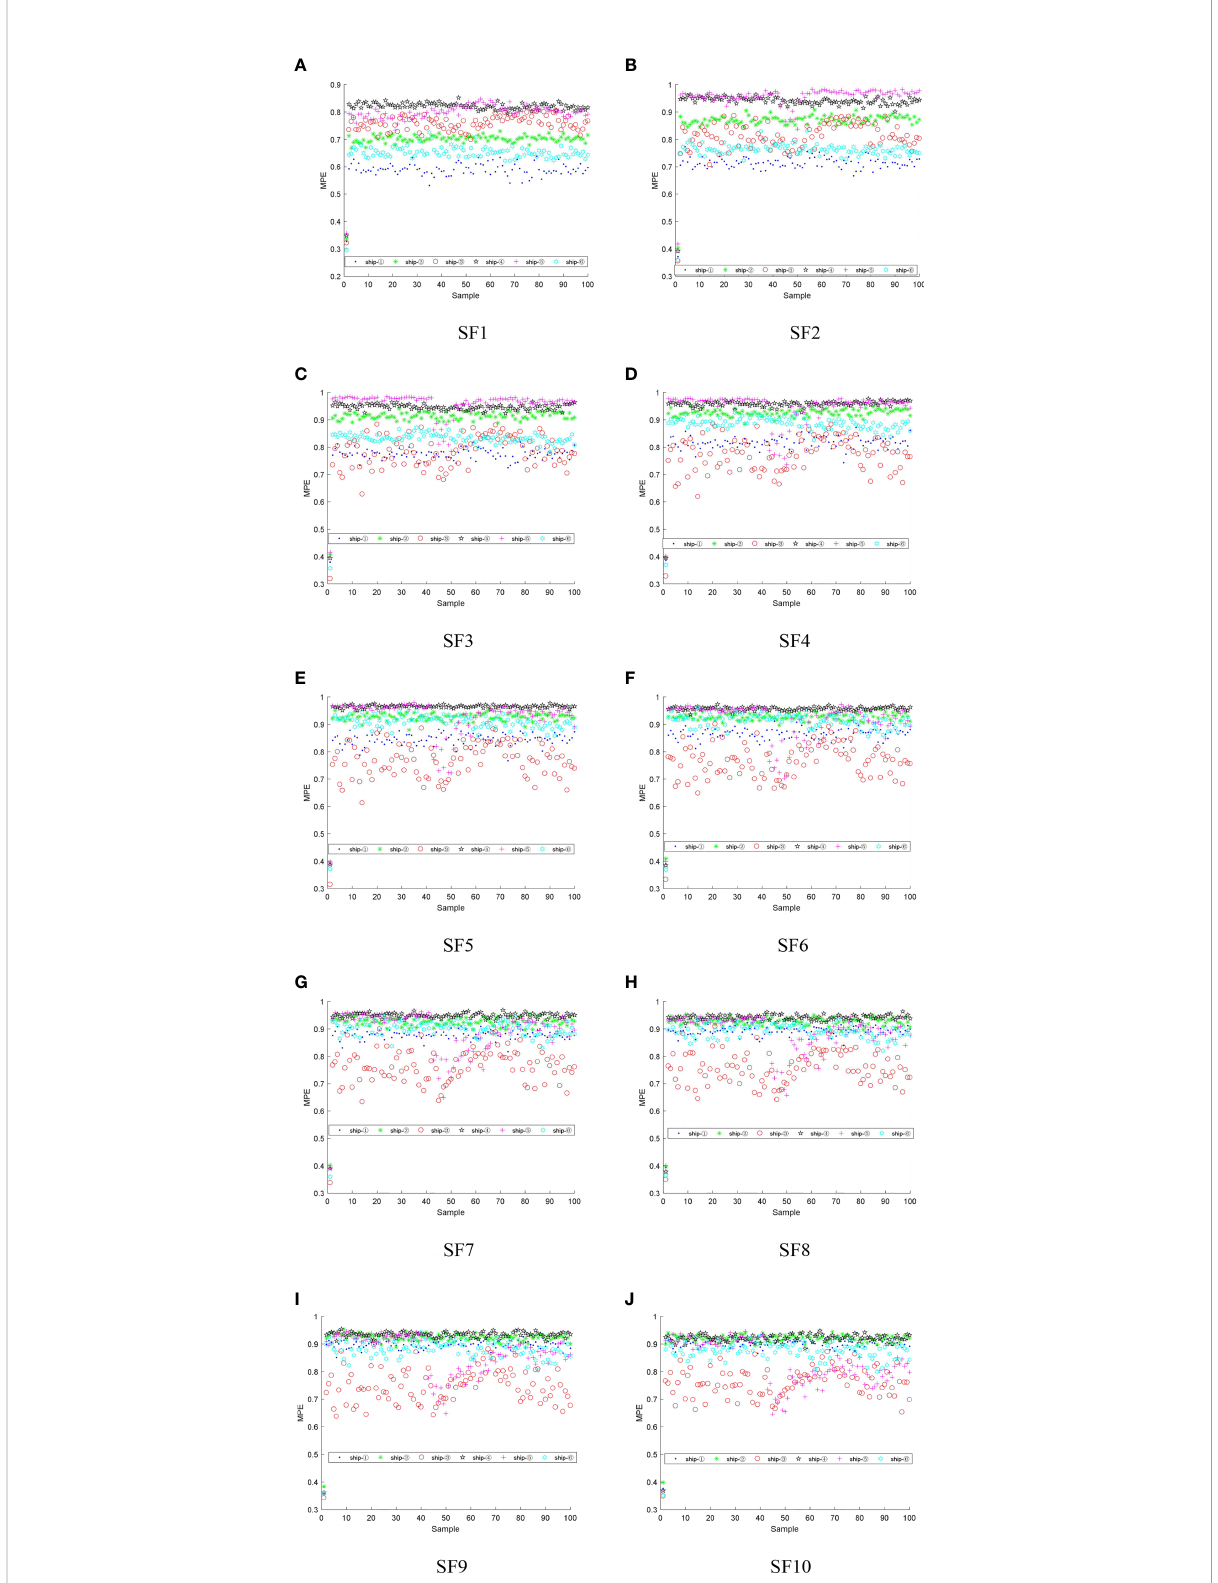
FIGURE 8 The feature distributions of MPE for six S-Ss under each SF: (A) SF1, (B) SF2, (C) SF3, (D) SF4, (E) SF5, (F) SF6, (G) SF7, (H) SF8, (I) SF9, (J)